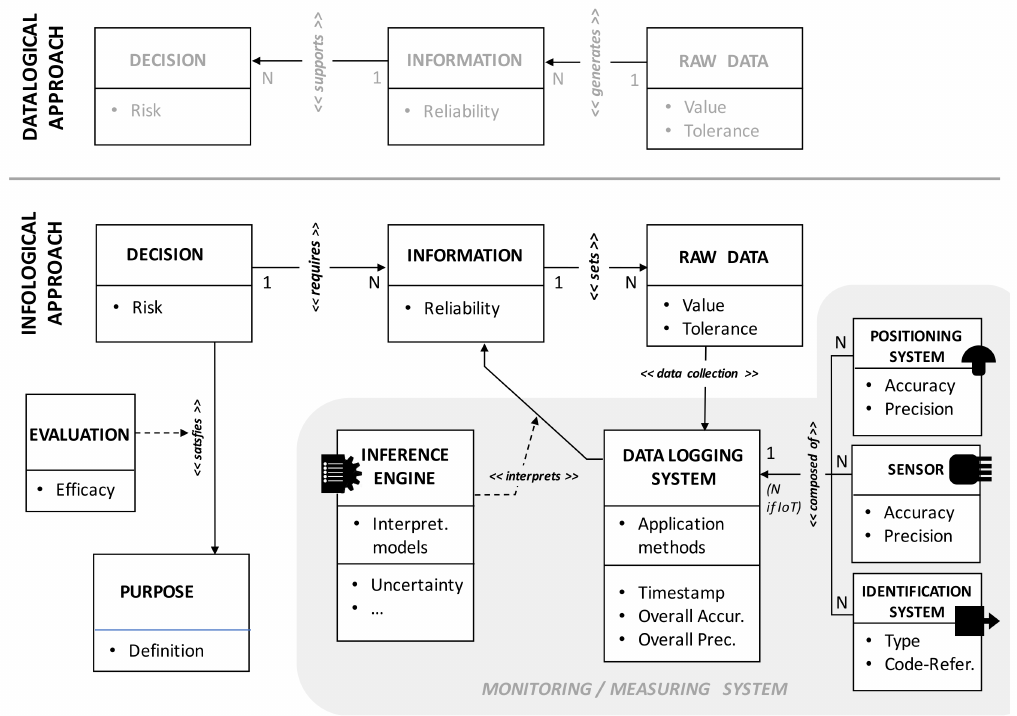
Figure 2. Comparison between infological and datalogical approach and scheme of the decisional chain according to a Knowledge Management logic (KM4.0). The Entity-Relationship graphic formalism based on Unified Modeling Language (UML) is here used. The name of relationships is indicated in the form << name >> . The relationships that implement their own methods are in turn linked (dotted lines) to specific classes (e.g., EVALUATION and INFERENCE